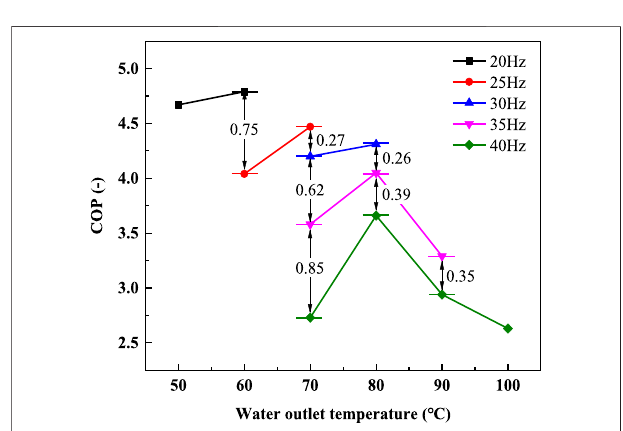
FIGURE 16| GCW and the corresponding COP at different compressor